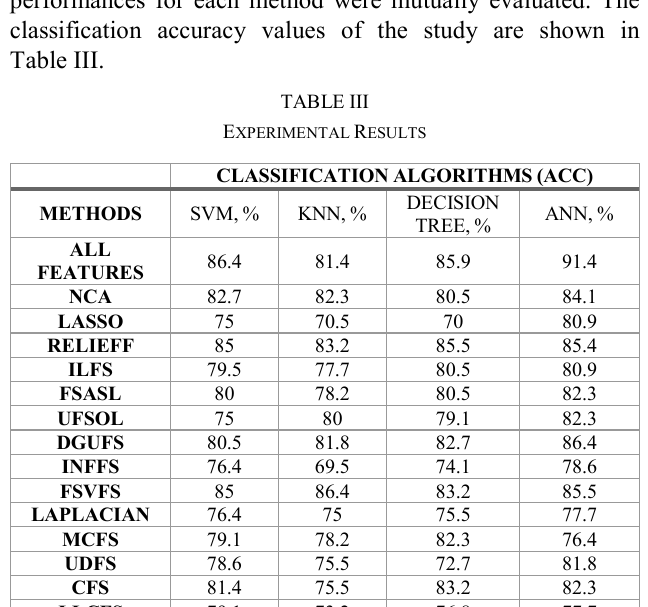
Table IV. Dimer, Lymph, WBC, Prot, AST parameters